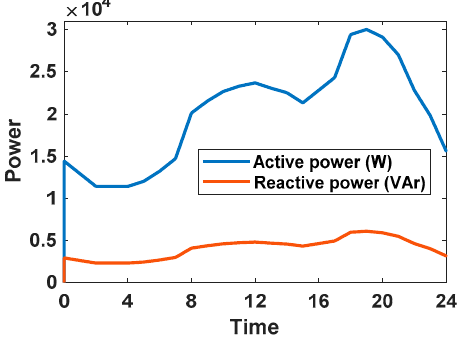
Figure 11. The load profile at node 3 in 24 h.